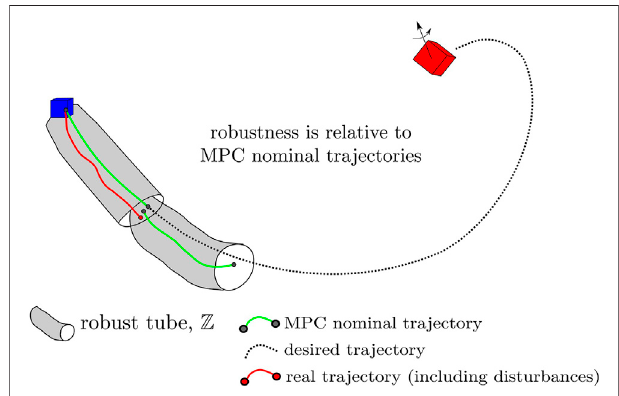
FIGURE 7 | A demonstration of the tube robustness guarantee. Robust tubes are produced around nominal reference trajectories which need not necessarily coincide with the real initial state and are in turn made to track a motionplanning referencetrajectory, x ref (black).Themaximumpossible deviation of x ref in any given timestep is treated as an additive uncertainty for tracking, and is dealt with via the tube robustness guarantee.